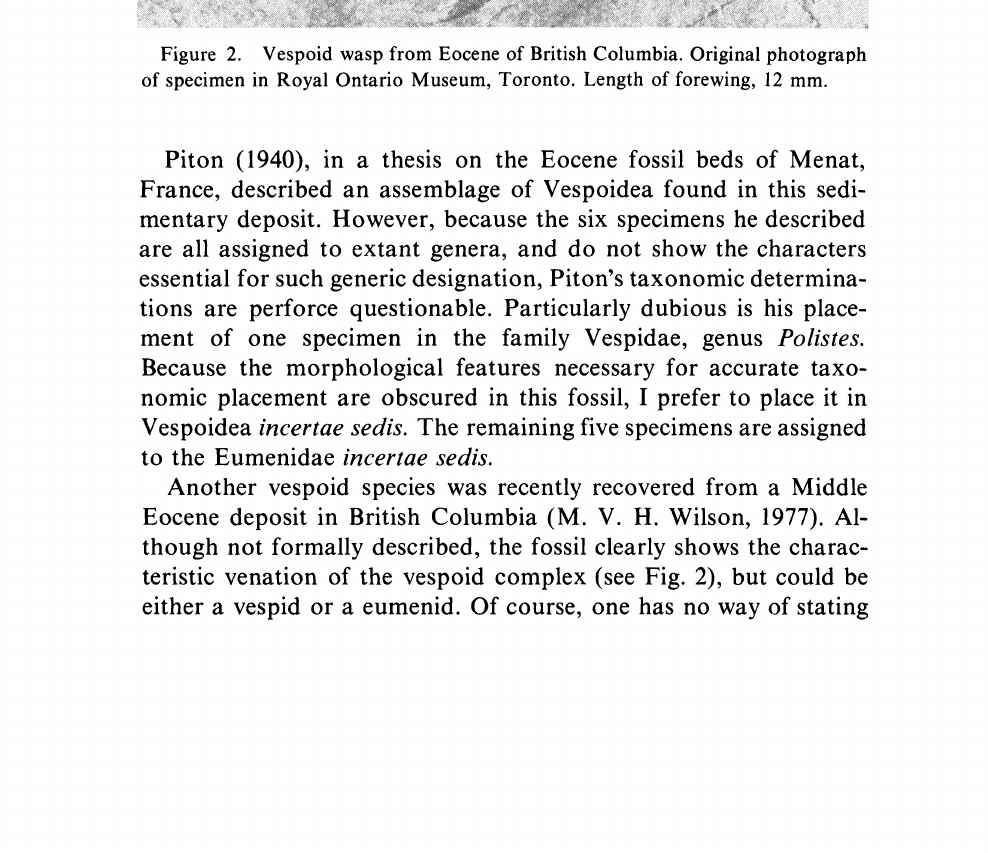
Figure 2. Vespoid wasp from Eocene of British Columbia. Original photograph of specimen in Royal Ontario Museum, Toronto. Length of forewing, 12